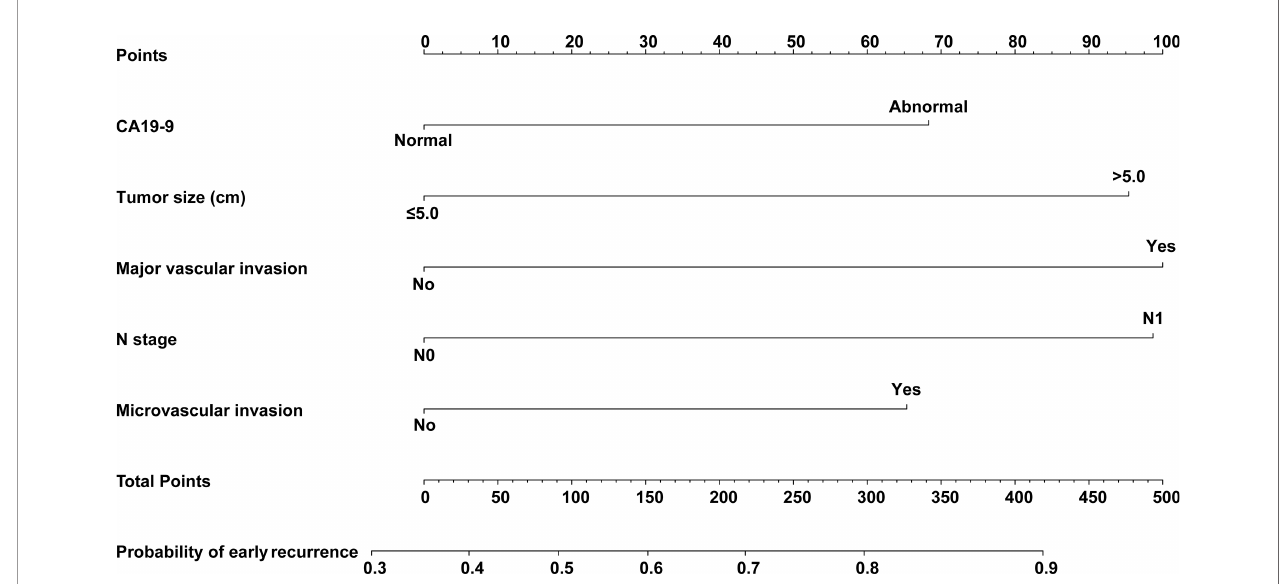
FIGURE 3 | Nomogram prediction model for predicting early recurrence of patients with ICC after radical